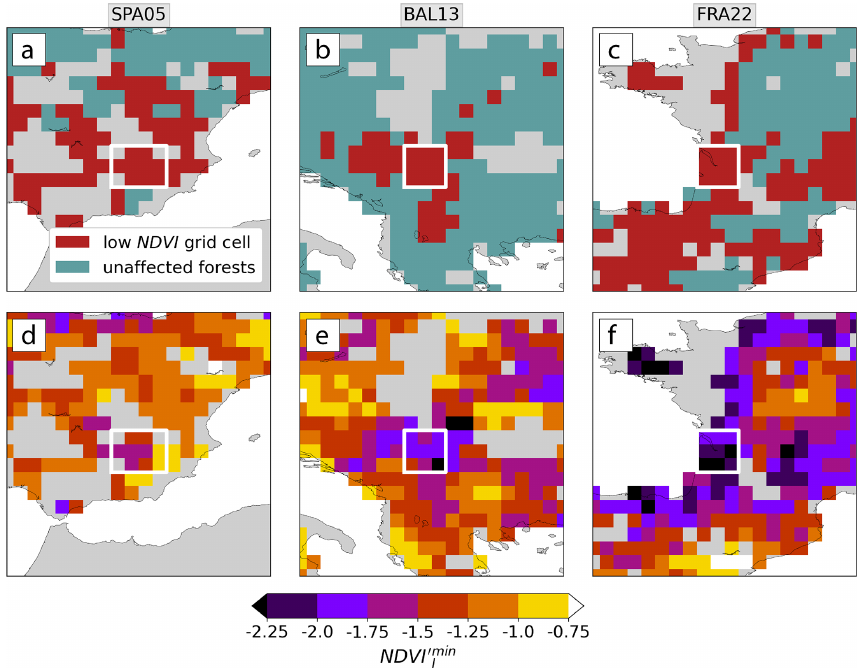
Figure 3. (a–c) Low-NDVI grid cells and (d–f) the event intensity measured by NDVI (cid:48) min J in (a, d) Spain in 2005, (b, e) the Balkans in 2013, and (c, f) France in 2022. The focus regions of SPA05, BAL13, and FRA22 are framed with white boxes.